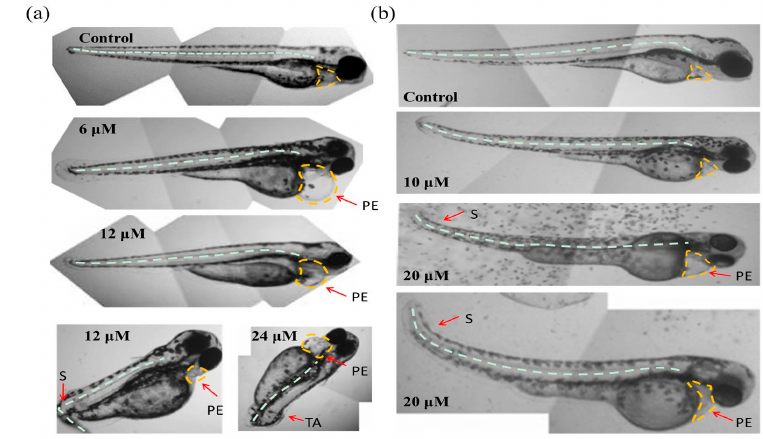
Figure 4. Abnormal embryos exposed to Tan-IIA. ( a ) Abnormal embryos in the chorionic embryo group; ( b ) Abnormal embryos in the dechorionated embryo group. S: scoliosis; PE: pericardial edema; TA: tail autolysis.